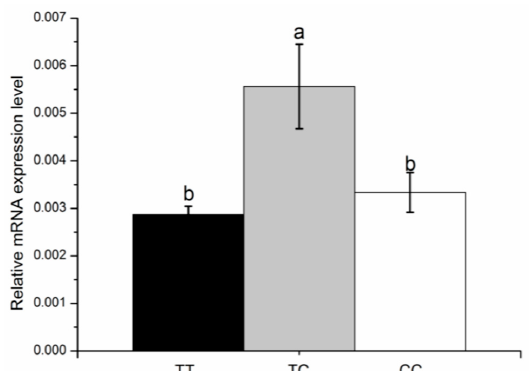
Figure 4. The effects of g.35989944T>C on KCNJ12 gene expression in 30 muscle tissues . The GAPDH gene was chosen as the internal reference gene for the qPCR analysis. Thirty muscle samples were genotyped, including three TT samples, 15 TC samples, and 12 CC samples.